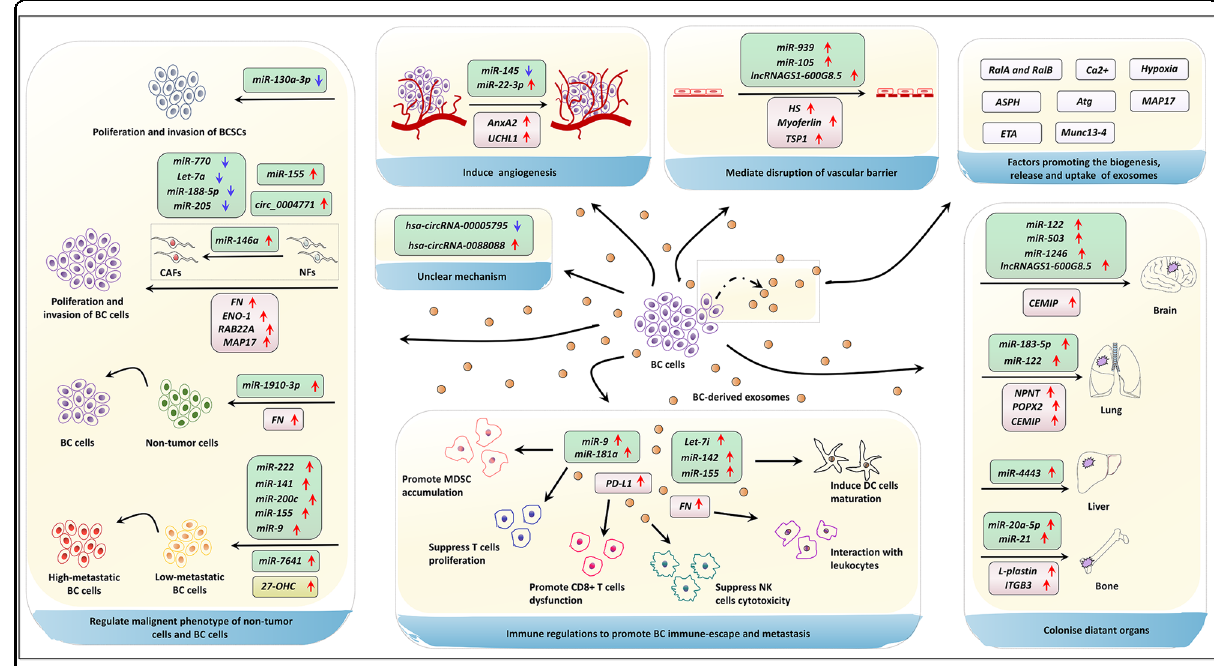
Fig. 3 The multifaceted roles and mechanisms of tumor-derived exosomal components in breast cancer metastasis. Exosomes could mediate metastatic initiation and progression of BC by transferring functional cargos. BC-derived exosomes can modify the malignant phenotype of non-tumor cells and low-metastatic BC cells such as promoting proliferation and invasion of BCSCs, promoting proliferation and invasion of BC cells through the transformation of NFs to CAFs. Besides, the speci fi c cargos are also involved in metastasis via inducing angiogenesis and disruption of vascular permeability. Furthermore, tumor-derived exosomes participate in organotypic metastasis. Through lymphatic circulation and blood circulation, primary BC-derived exosomes can transfer proteins (e.g., NPNT) and nucleic acids (e.g., miRNAs) to distant organs, thus inducing colonization and in fi ltration of new sites. The key procedure for establishing a permissive environment for BC metastasis is also related to interaction between BC cells and immune cells to escape immune surveillance. For example, BC exosomes carried PD-L1 could promote CD8 + T-cell dysfunction to facilitate immune-suppressing and metastasis. Most studies have con fi rmed the expression levels and metastasis capabilities of cargos in exosomes involving in BC metastasis, while a few studies only con fi med the genetic changes of cargoes by sequencing. Finally, the role of exosomes in BC metastasis is also associated with factors affecting exosomal biogenesis, release and uptake. For example, hypoxia and ETA can promote BC metastasis by promoting the release of exosomes. ↑ upregulation, ↓ downregulation, breast cancer BC, human breast cancer stem cells BCSCs, normal fi broblasts NFs, cancer-associated fi broblasts CAFs, interleukin IL, tumor necrosis factor TNF, microRNA miRNA, long noncoding RNA lncRNA, circular RNA circRNA, extracellular matrix protein nephronectin NPNT, cell migration-inducing and hyaluronan-binding protein CEMIP, ubiquitin carboxyl-terminal hydrolase isozyme L1 UCHL1, integrin β 3 ITGB3, 27-hydroxycholesterol 27-OHC, thrombospondin-1 TSP1, fi broblast growth factor FGF, platelet-derived growth factor PDGF, annexin A2 AnxA2, enolase-1 ENO-1, heparan sulfate HS, autophagy and autophagy-related genes Atg, endothelin receptor A ETA, asparaginyl β -hydroxylase ASPH, myeloid-derived suppressor cells MDSC, dendritic cells DC, and programmed death-ligand 1